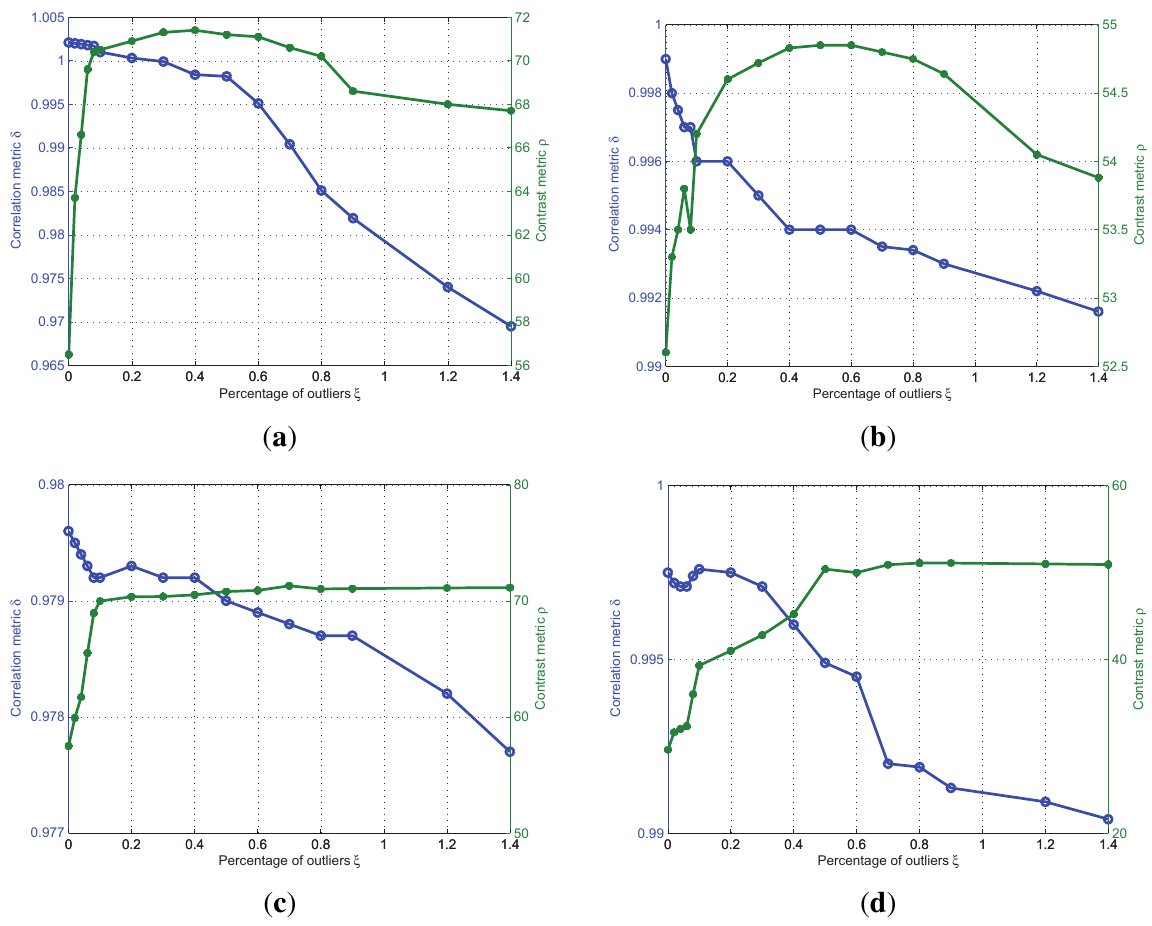
Figure 6. Correlation metric ρ and contrast metric δ for different percentages of outliers in pixels for our proposed PDADVS algorithm: ( a ) Cuprite Moffett _ igm ; and ( d ) Lun.lake _ igm . 03